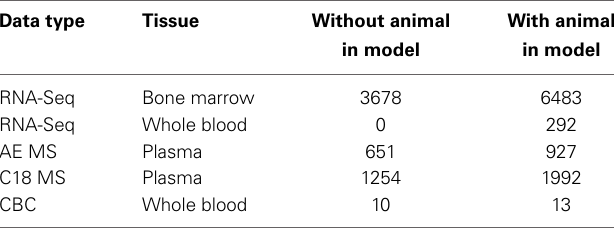
contrasting seven timepoints for RNA-Seq, and 5 timepoints for metabolomics.